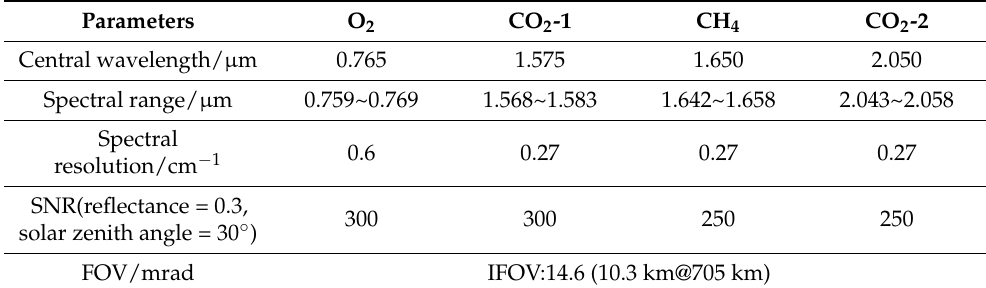
Figure 31. Composition of the GMI load optical system ( above figure) and physical photos ( bottom figure). Table 3. Main performance index of